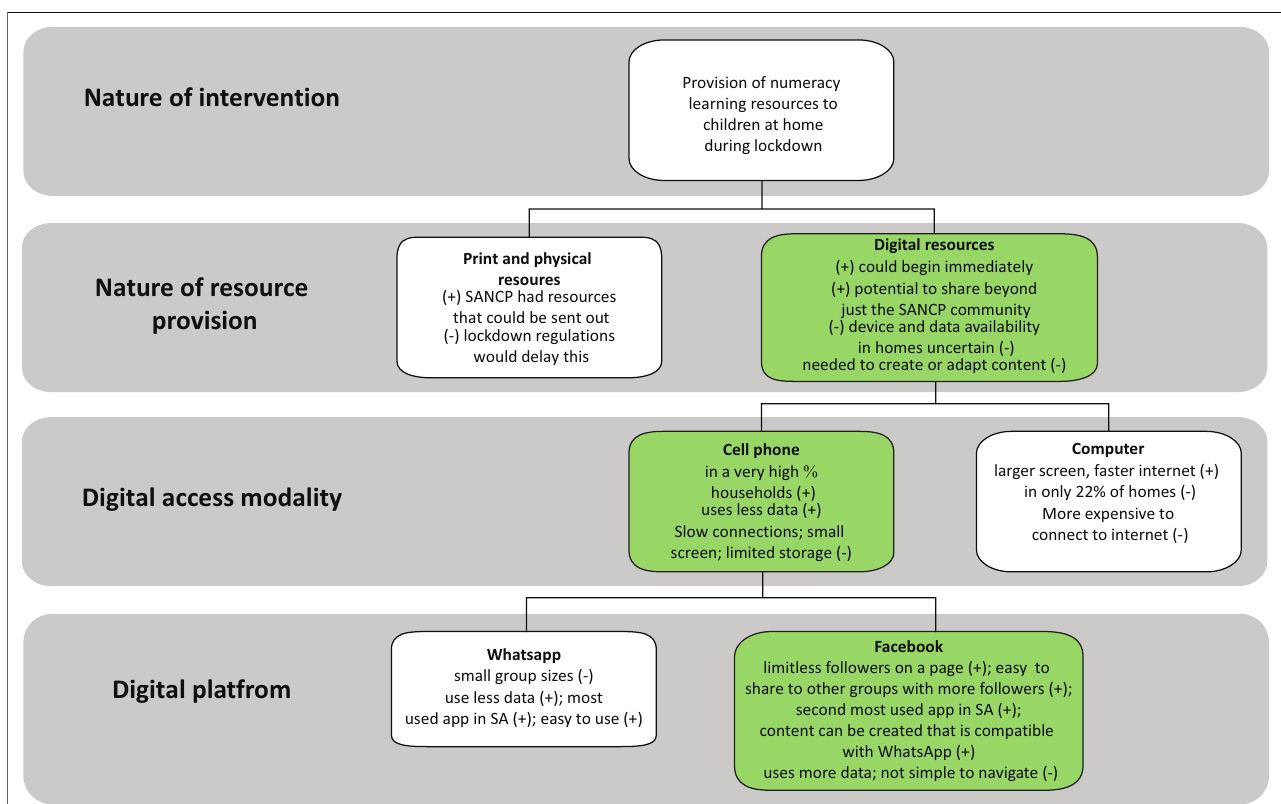
FIGURE 1: Digital decision-making process including constraints and